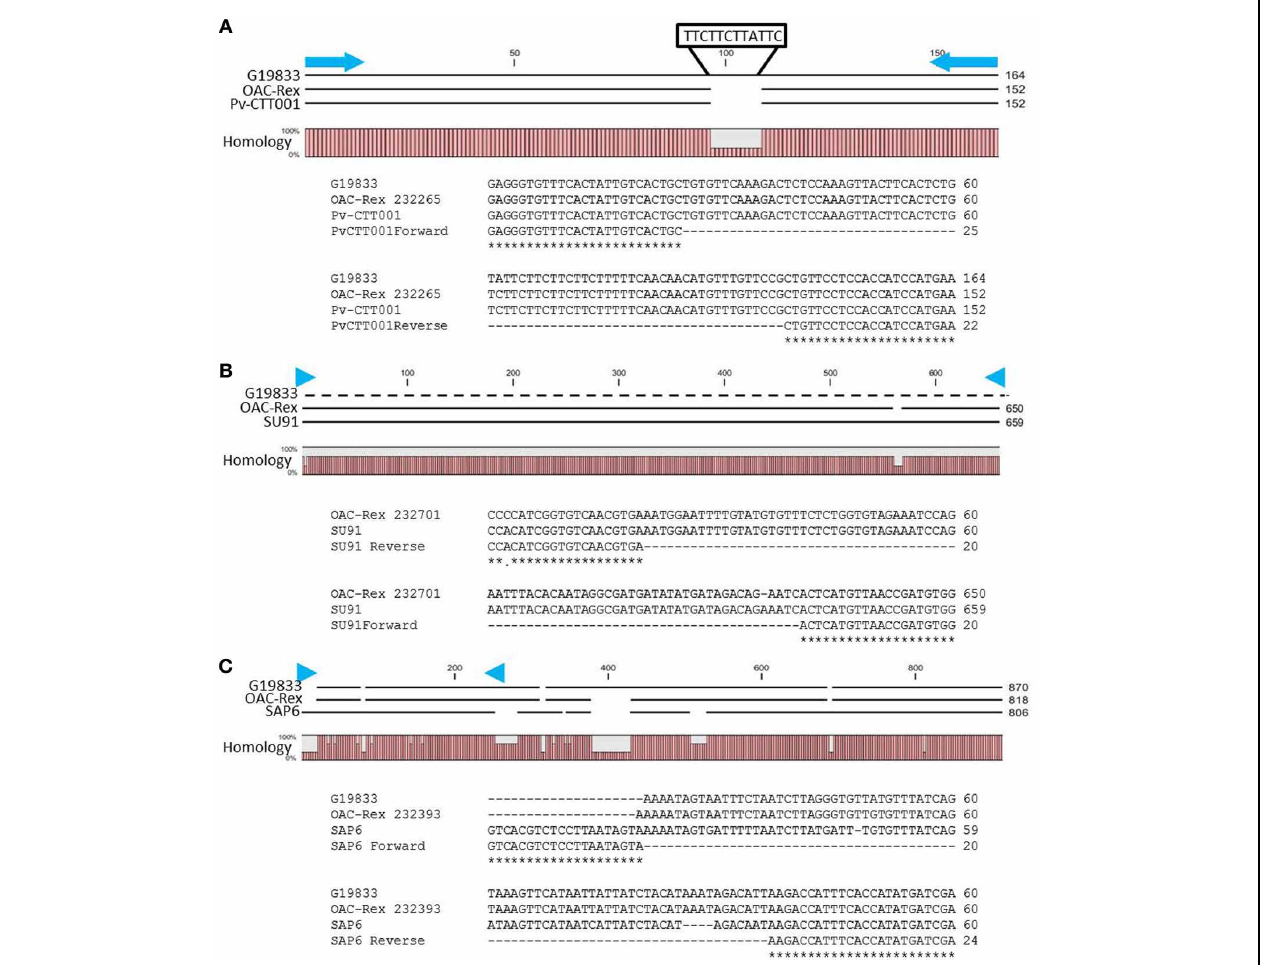
FIGURE 2 | Alignment of genomic DNA sequences associated with CBB-resistance markers; (A) Pv- CTT001, (B) SU91, and (C) SAP6. The degree of conservation of the genomic sequences in G19833 and OAC-Rex between the marker PCR primers is given. The G19833 fragment amplified by the Pv- CTT001 would be expected to be 12 bp larger than the OAC-Rex sequence because of the insert noted (A) . For the SU91 marker (B) , a null sequence is provided for the G19833